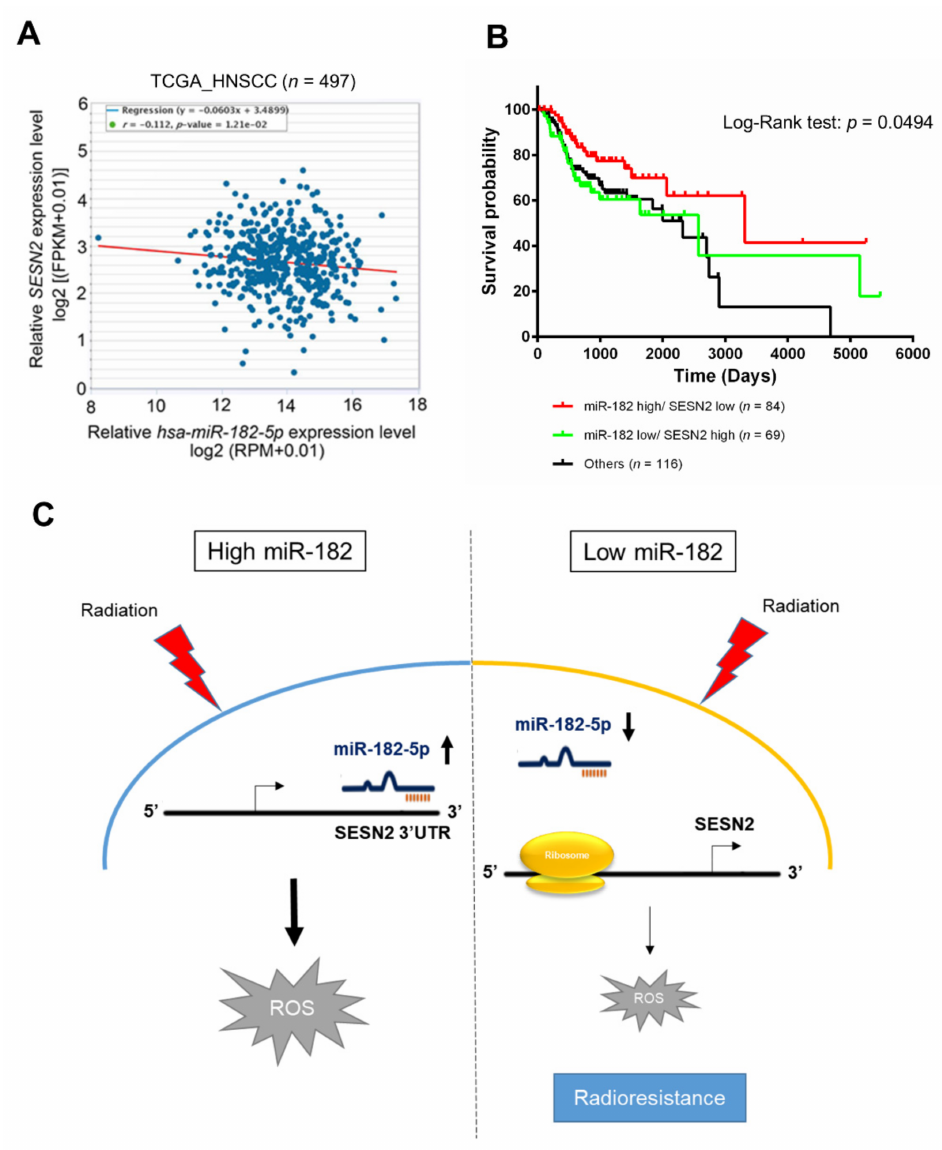
Figure 7. Correlative analysis of miR-182-5p and SESN2 expression on the survival rates of HNSCC patients who received radiotherapy. ( A ) Scatter plot showing a trend of negative correlation between hsa-miR-182-5p and SESN2 mRNA using RNA-Seq analysis in the TCGA-HNSC dataset. ( B ) Com- parison of overall survival rates in HNSCC patients who received radiotherapy. The expression of hsa-miR-182 combined with SESN2 gene expression was stratified by three groups: hsa-miR182 high with SESN2 low, hsa-miR-182 low plus SESN2 high, and others. ( C ) Schematic model showing the mechanism by which the miR-182-5p/SESN2 regulatory pathway mediates radiation-induced antioxidant effects and the radiation